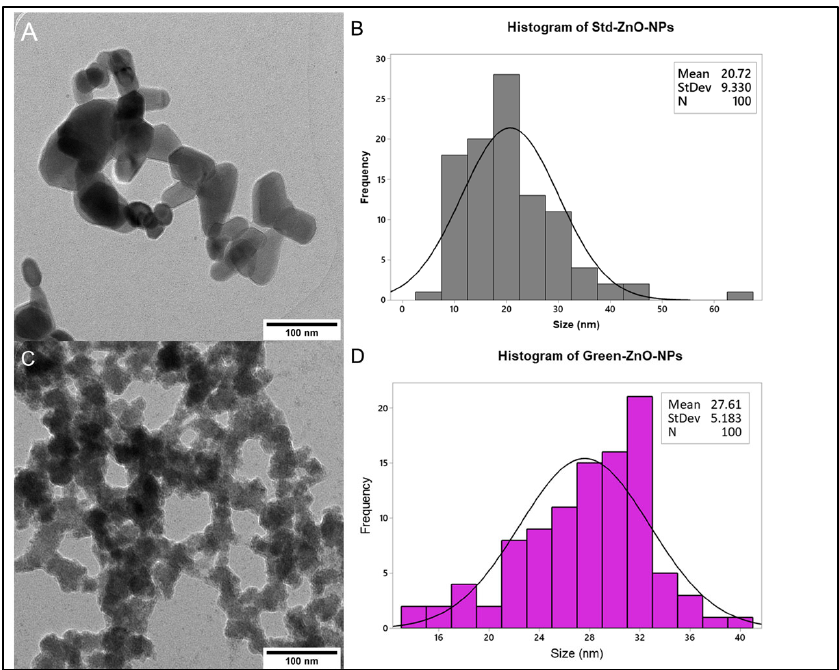
Figure 6. ( A ) Transmission electron microscopy images of Std ‐ ZnO ‐ NPs and ( B ) their corresponding histogram of particle size distribution ( n = 100). ( C ) Transmission electron microscopy images of Green ‐ ZnO ‐ NPs and ( D ) their corresponding histogram of particle size distribution ( n = 100).